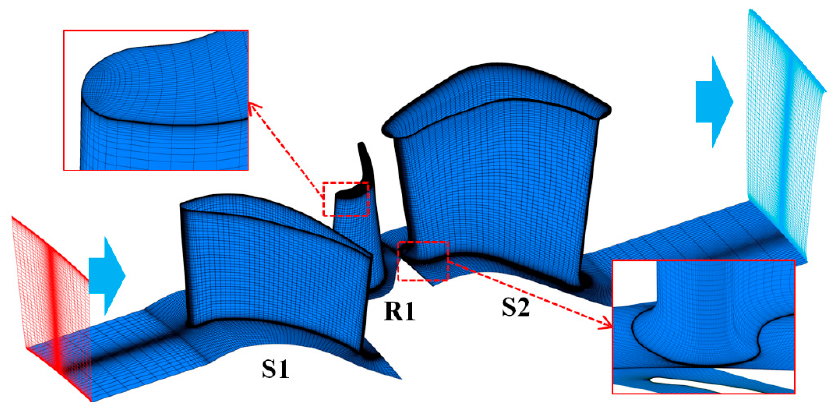
Figure 2. Schematic of computational domain of the 1.5-stage turbine.